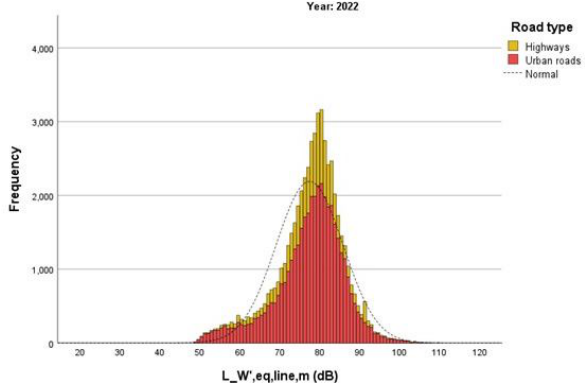
Figure 2: Distributions of the directional sound power per meter values for 2022 simulation; bars stacked by road